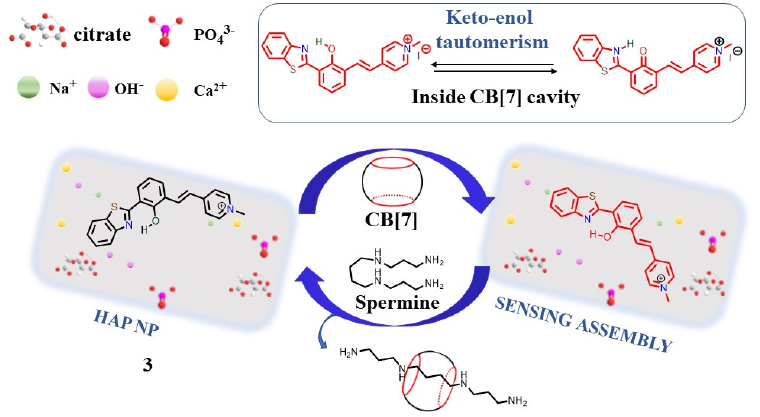
Figure 4. Schematic representation of the three ‐ component supramolecular sensing assembly for spermine, spermidine, and cadaverine [46].